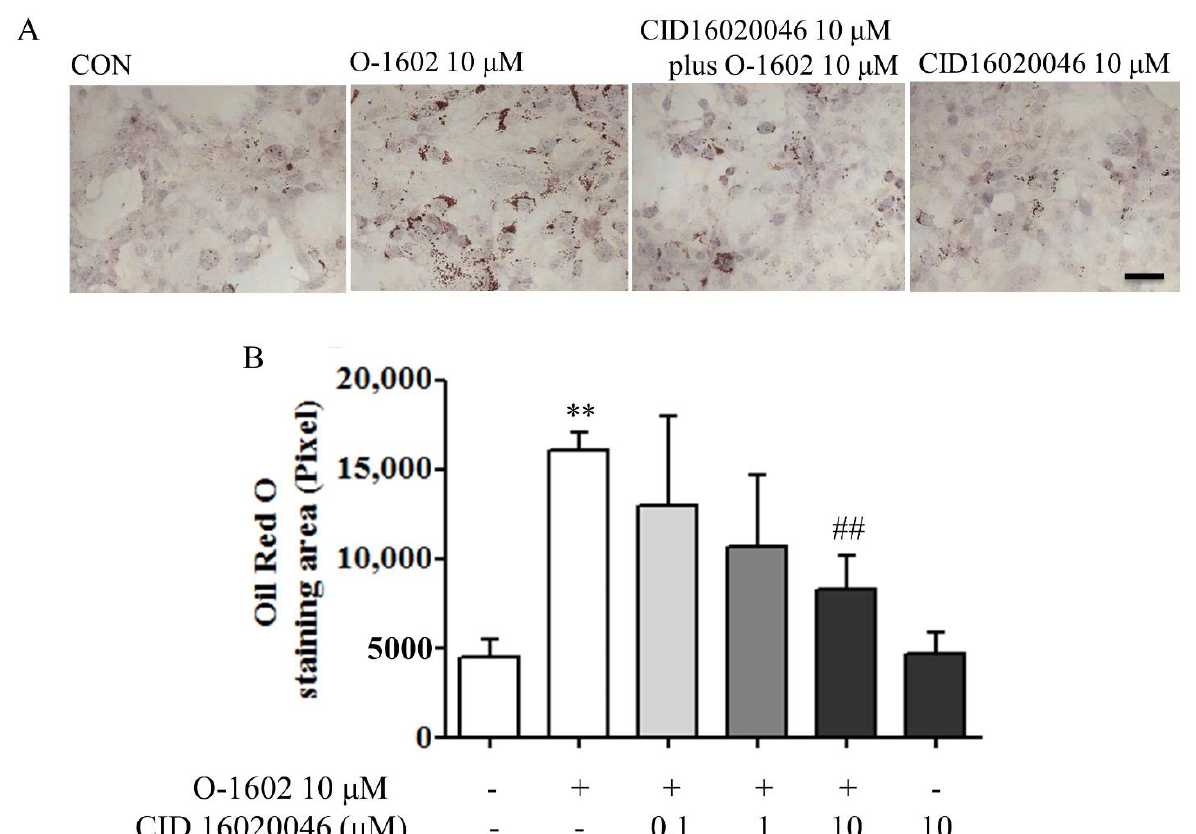
Figure 2. CID16020046 antagonizes O-1602-induced lipid accumulation. ( A ) Oil red O staining. Hep3B cells were pretreated with different concentrations of CID16020046 for 30 min and then treated with 10 µ M O-1602 for 48 h. The red staining shows lipid droplets. The scale bar means 20 µ m. ( B ) Histogram showing lipid accumulation. Oil red O staining was analyzed using ImageJ software. Data are from three individual experiments and expressed as mean ± SD. ** p < 0.01, compared with the non-treated group; ## p < 0.01, compared with O-1602-treated group.